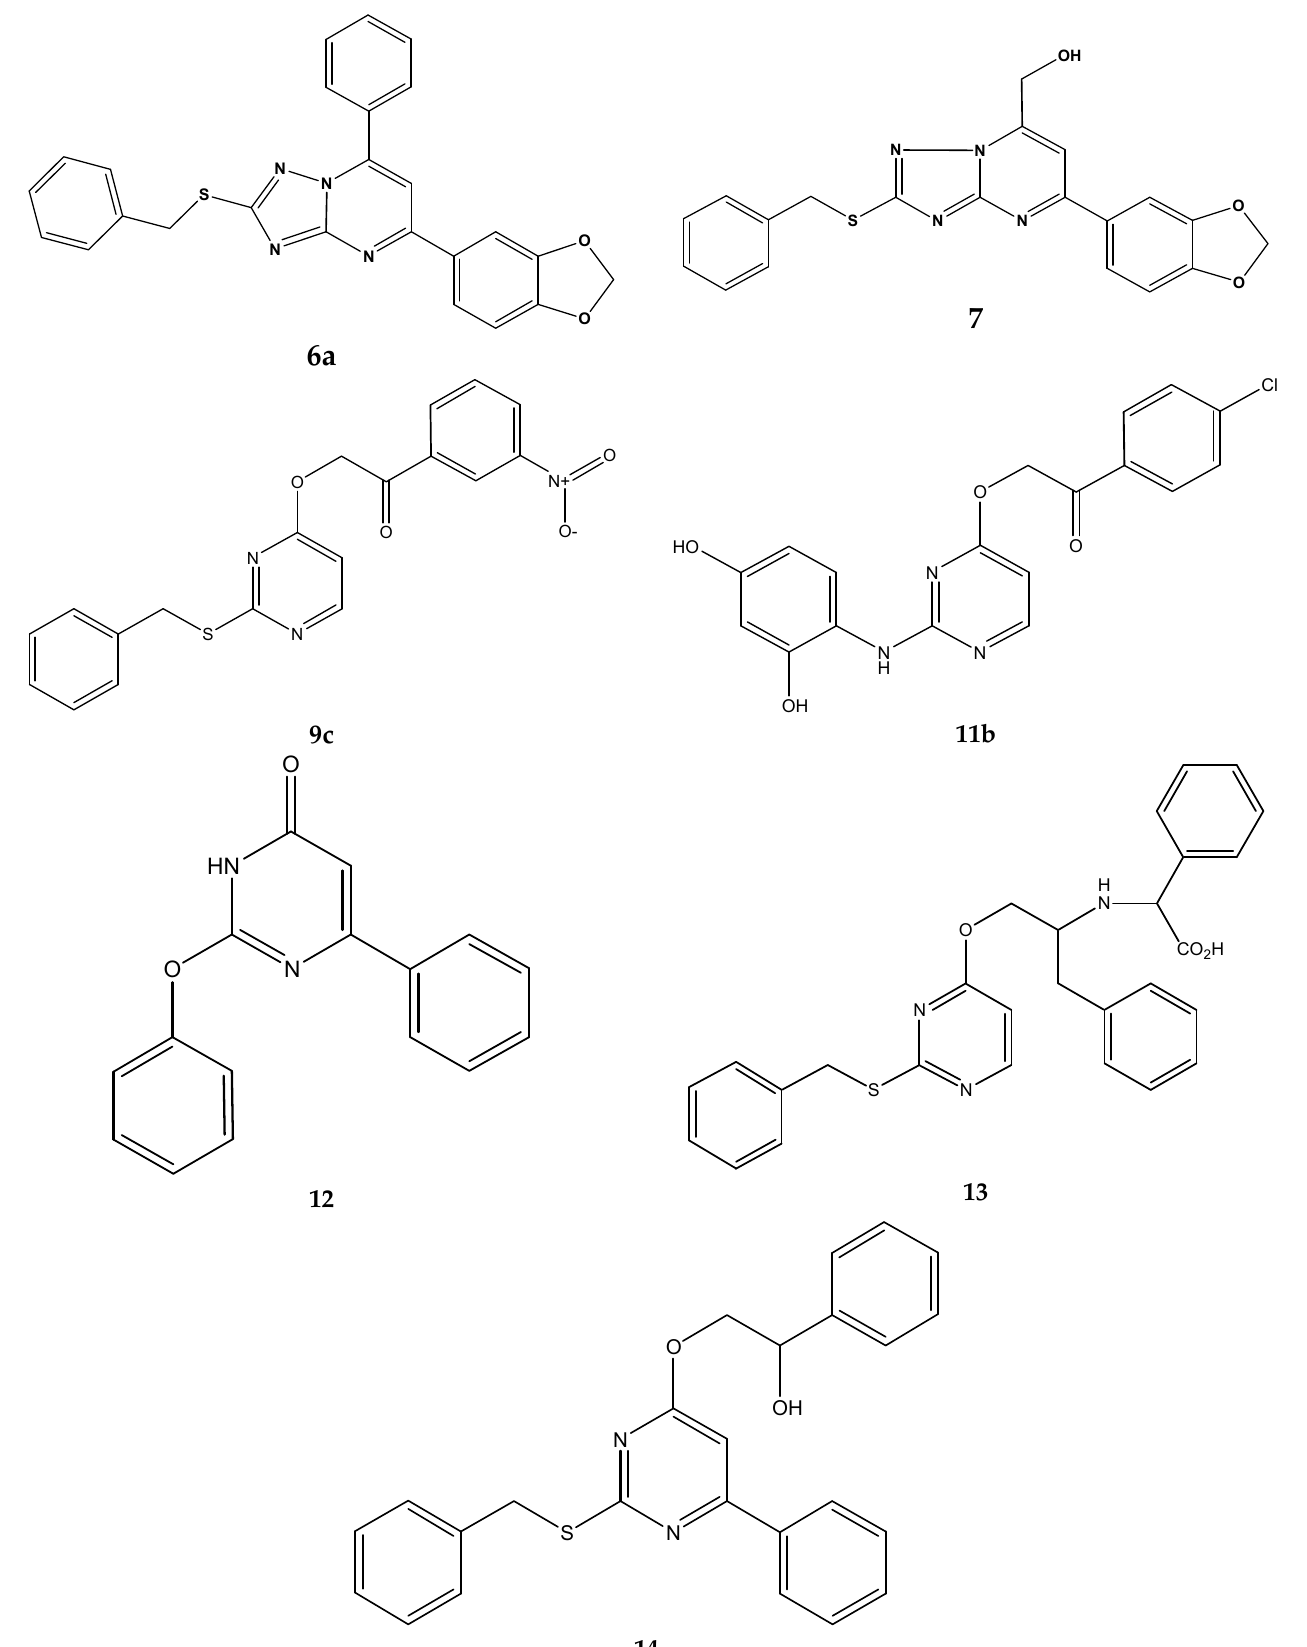
Figure 3. Structures of the selected compounds.